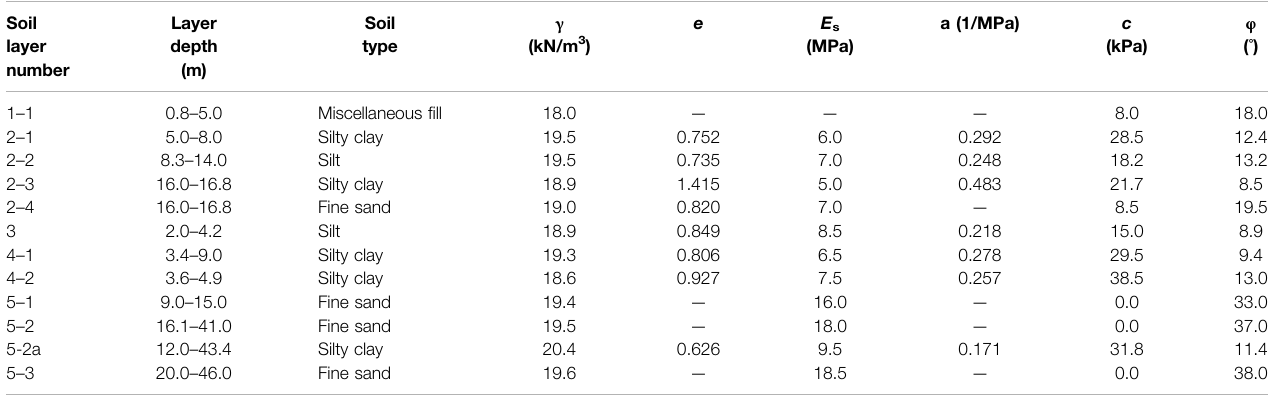
TABLE 1 | Physical and mechanical characteristics of the soil layers. Soil